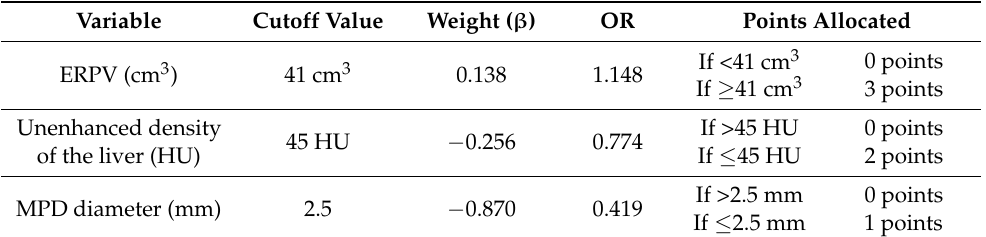
Table 6. Alternative score for the assessment of the risk of CRPF using Model